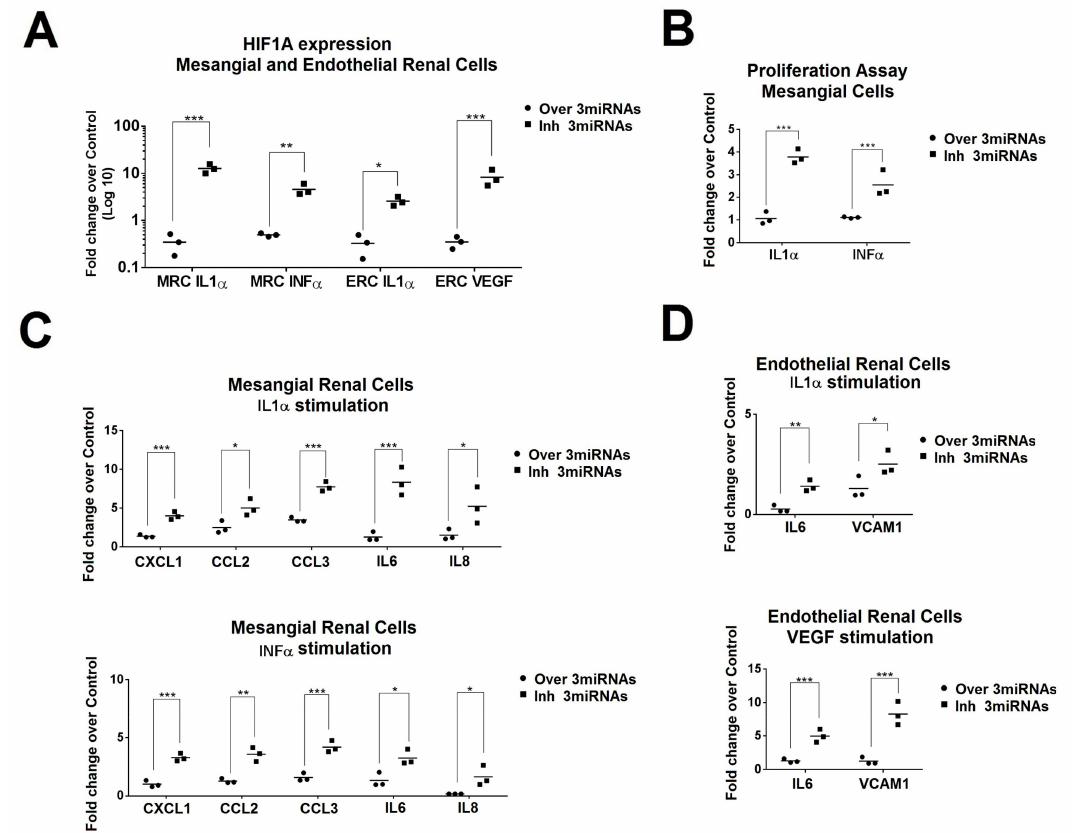
Figure 6. E ff ect of exosomal miRNAs to mesangial and endothelial renal cells. ( A ) HIF1A expression levels were analyzed by quantitative real-time in overexpressed or inhibited primary mesangial and endothelial renal cells after interleukin-1 alpha (IL1 α ), interferon alpha (INF α ) or vascular endothelial growth factor (VEGF) stimulation. Overexpression or inhibition was performed for the three studied miRNAs (miR-31-5p, miR-107, and miR-135b-5p). MRC = mesangial renal cells. ERC = endothelial renal cells. Values were normalized using GADPH and 18S . Data are expressed in Log10 scale. *** p < 0.0005, ** p < 0.005, and * p < 0.05. ( B ) Fold change of proliferation in mesangial renal cells with overexpression or inhibition of the miR-31, miR-107, and miR-135b-5p (over 3miRNAs or Inh 3miRNAS, respectively). Control conditions were obtained with mimic or anti miR-control. *** p < 0.0005. ( C ) Quantitative real-time RT-PCR analysis shows the relative mRNA levels of CXCL1 , CCL2, CCL3, IL6, and IL8 in IL1 α - and INF α -stimulated renal mesangial cells (MRCs). Values were normalized using GADPH and 18S . Fold change was calculated over the control condition (mimic miR-control or anti